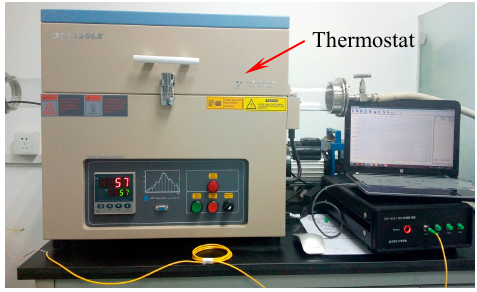
Figure 9. Photo of the experimental setup for temperature testing.